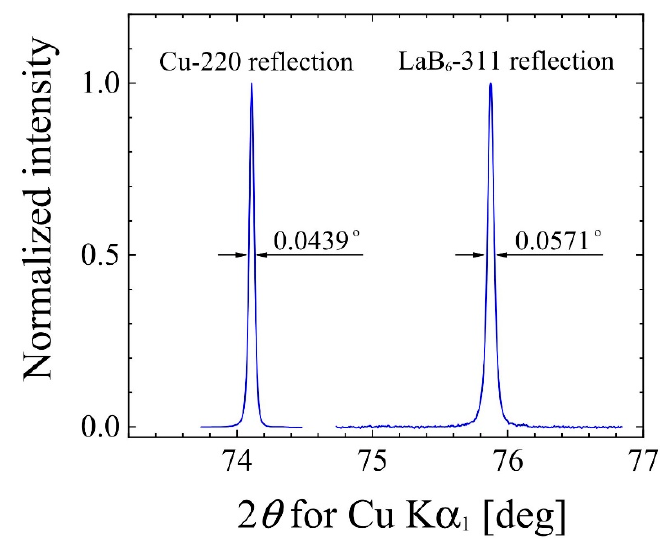
Figure 1. Comparison of diffraction peaks of the Cu-220 reflection and LaB 6 -311 reflection.